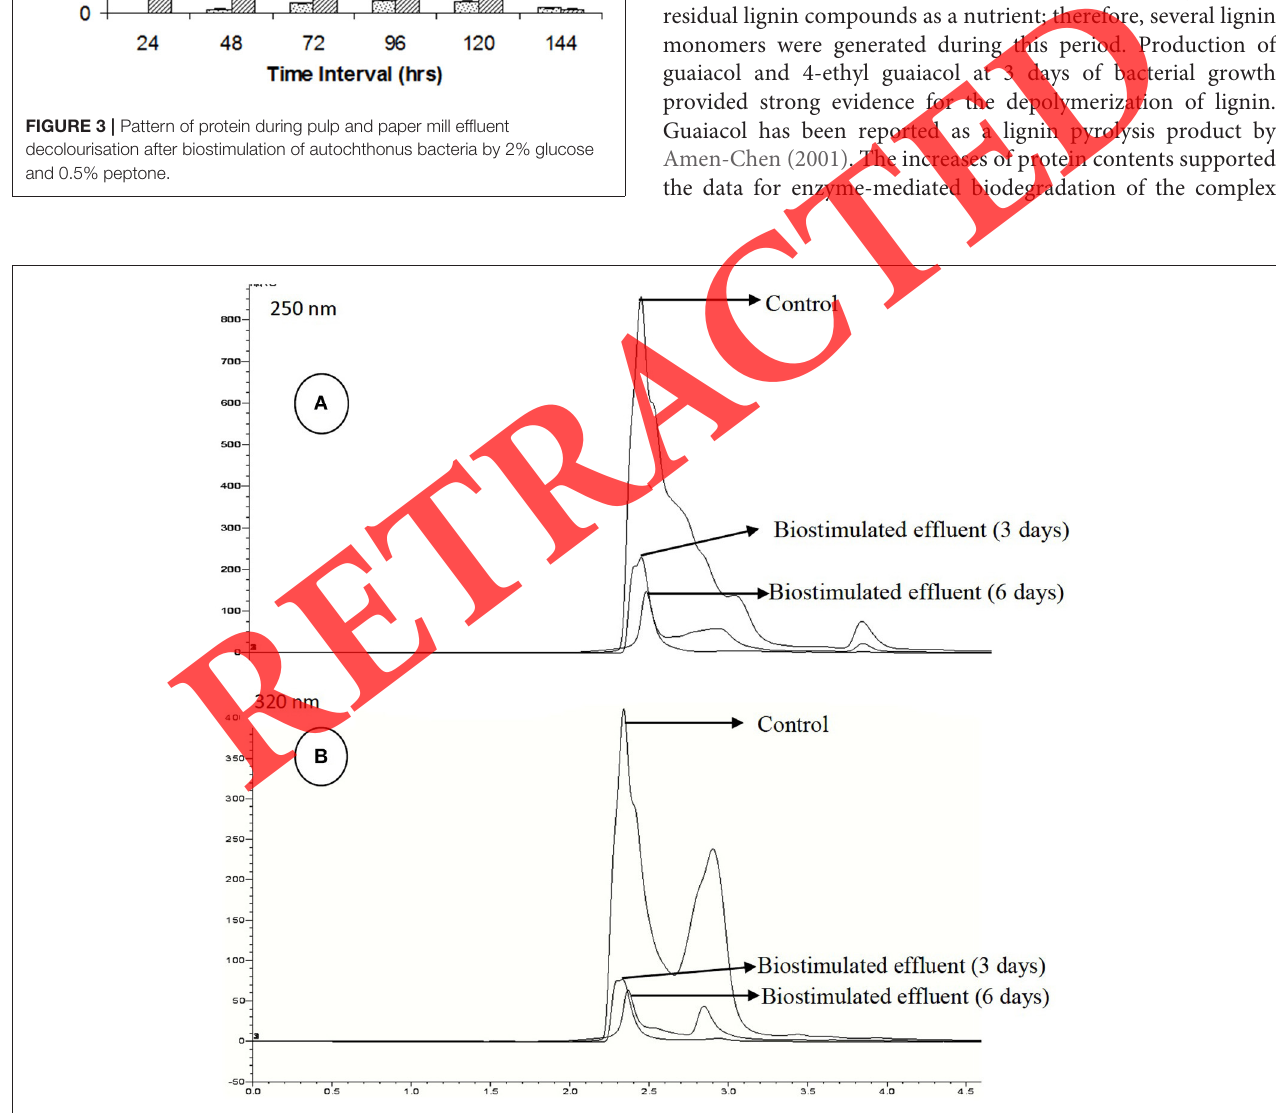
FIGURE 4 | HPLC analysis of decolorized pulp and paper mill effluent at different time interval on 250nm (A) and 320nm absorbent (B) .